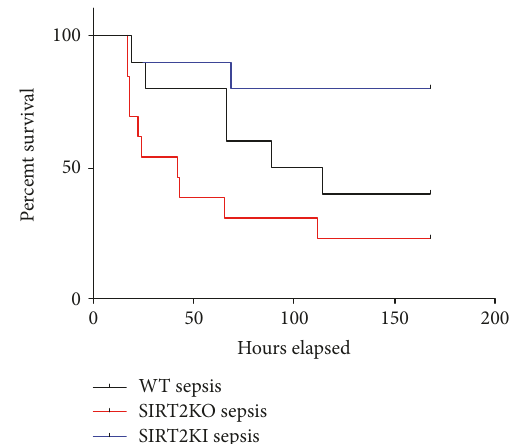
Figure 5: SIRT2 modi fi cation impacts sepsis survival. We studied 7- day survival rates in WT, SIRT2KO, and SIRT2KI mice with sepsis. WT sepsis mice showed a 40% 7-day survival rate; SIRT2KO sepsis mice was 10% while SIRT2KI sepsis mice showed an 80% 7-day survival